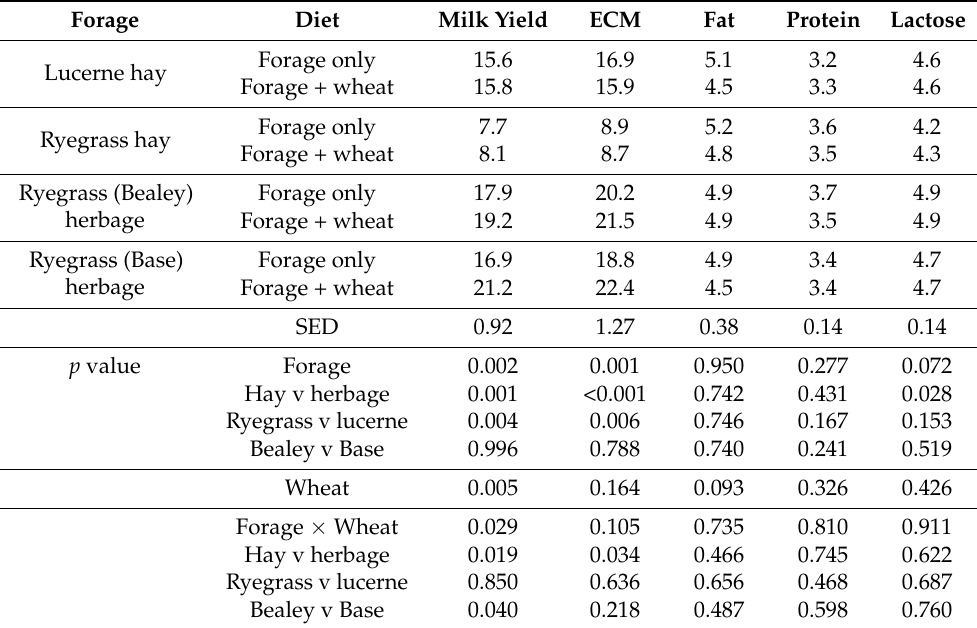
Table 3. Influence of forage type and the addition of wheat to the diet on milk yield (kg/cow per d),